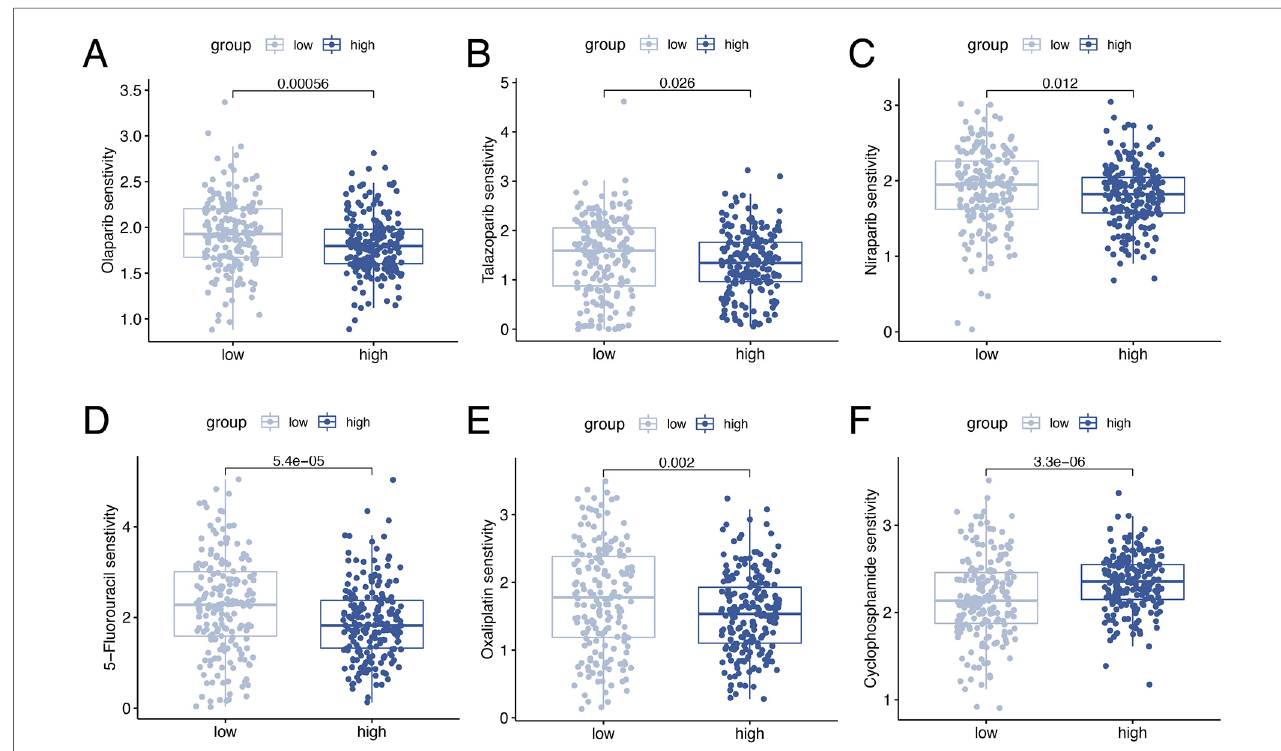
FIGURE 9 Drug sensitivity analyses. Analysis of drug sensitivity differences in olaparib ( A ), talazoparib ( B ), niraparib ( C ), 5- fl uorouracil ( D ), oxaliplatin ( E ), and cyclophosphamide ( F